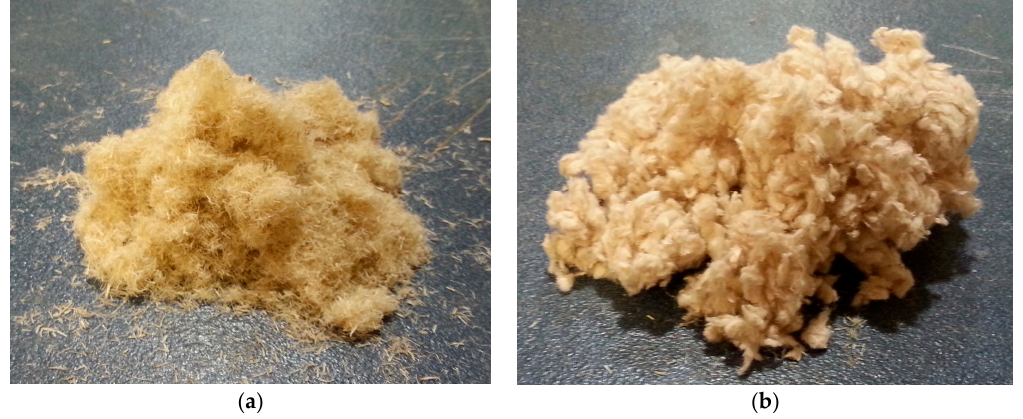
Figure 2. Digested hemp fibre ( a ) and digested harakeke fibre ( b ).